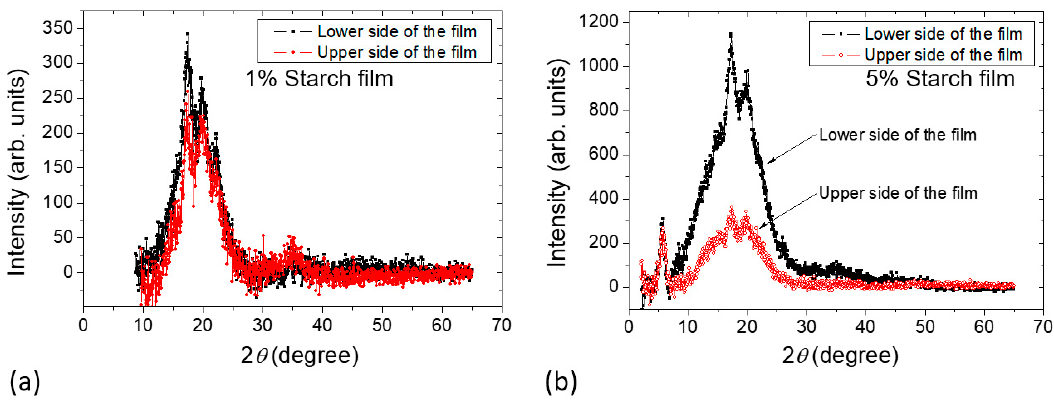
Figure 9. X-ray patterns of films prepared from ( a ) Sample c containing 1% starch in H 2 O ( w / v ) and ( b ) Sample d containing 5% starch in H 2 O ( w / v ).